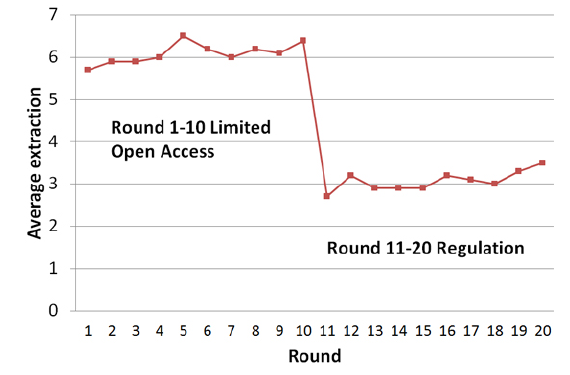
Fig. 1 . Average extraction per